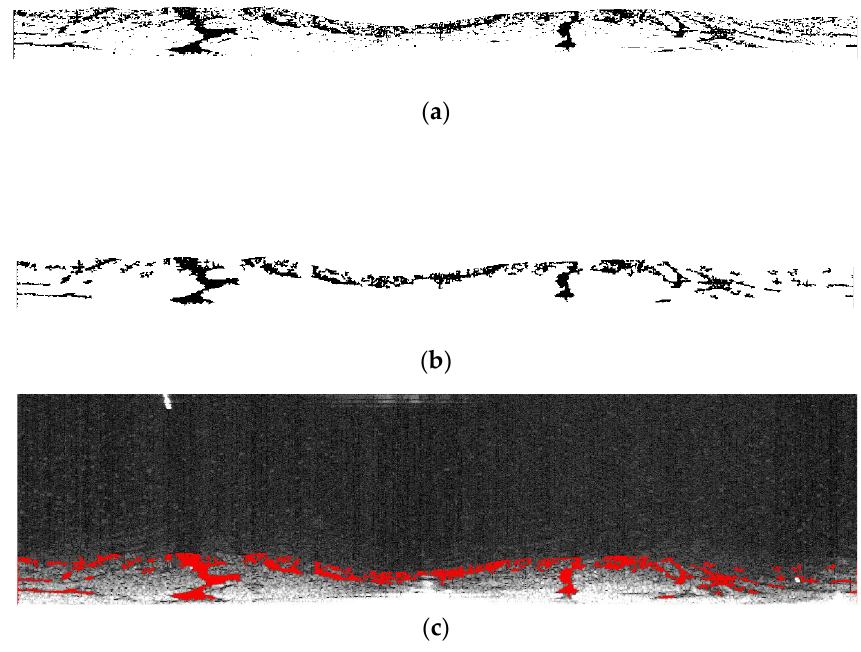
Figure 13. Oil spill segment detected based on adaptive thresholding proposed by Bradley et al.: ( a ) oil spill segment detected by Bradley’s method; ( b ) oil spill segment with noise removed; and ( c ) oil spill segment marked in red on the radar image.